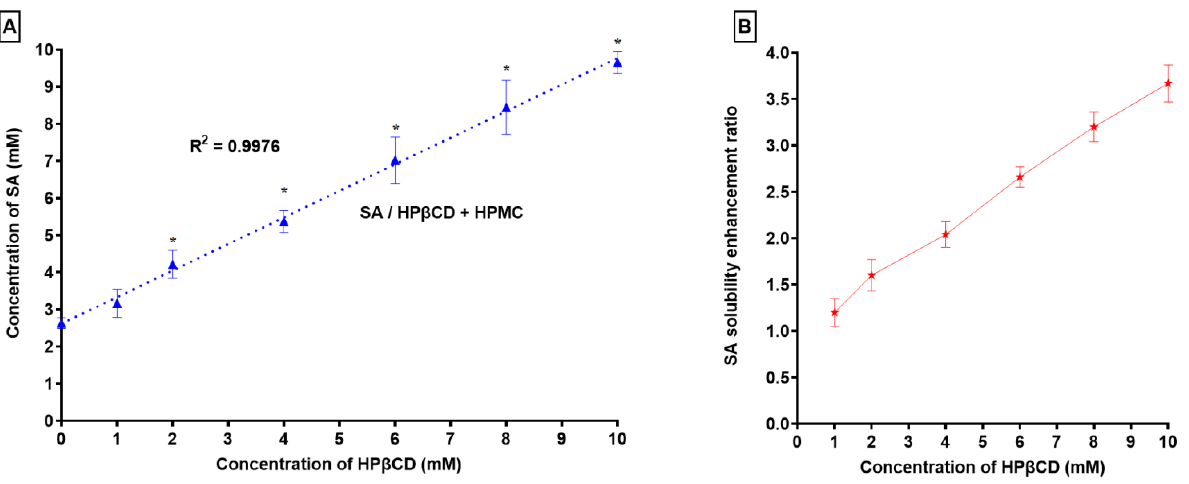
Figure 1. ( A ) Phase solubility profile of SA in presence of HP β CD and HPMC (5%) and ( B ) SA solubility enhancement ratio in presence of HP β CD and HPMC (5%), * p < 0.05 as compared to S 0 . The solubility of SA was found to be 3.67 times higher in water in the presence of HPβCD/HPMC. The K c and C e values were found to be 961.90 M −1 and 2536.56,